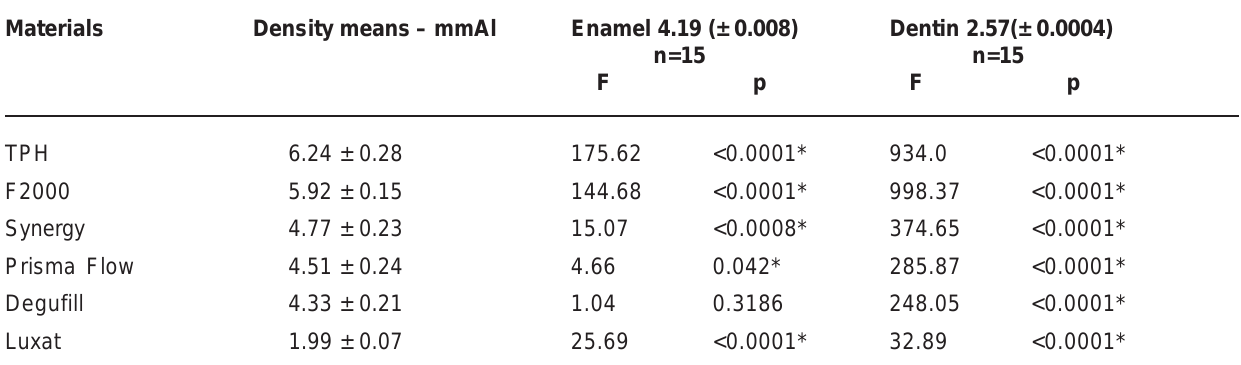
* Groups with the same letter are not significantly different. p<0.05 TABLE 4- Density values of restorative materials expressed as equivalent of aluminum thickness (mmAl). Comparison results among the groups and regarding enamel and